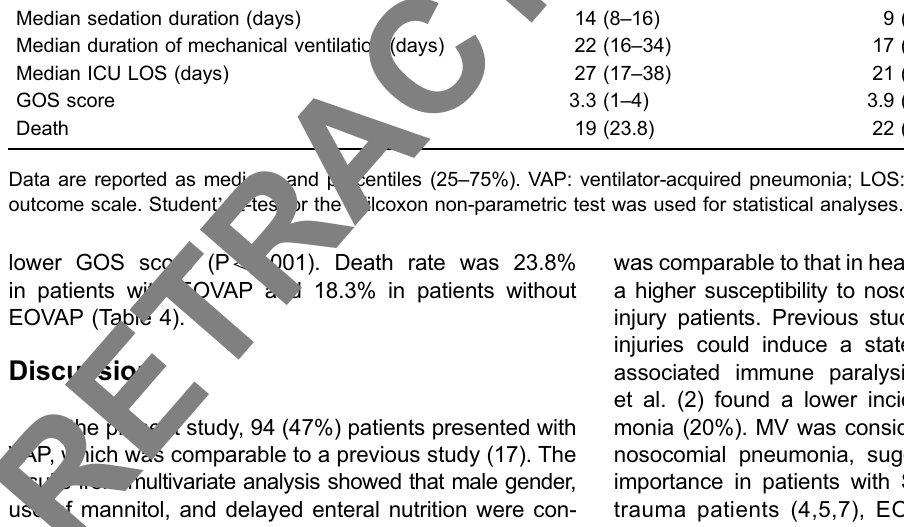
Data are reported as number and percentage. Table 4. Events in the intensive care unit (ICU). Characteristics in